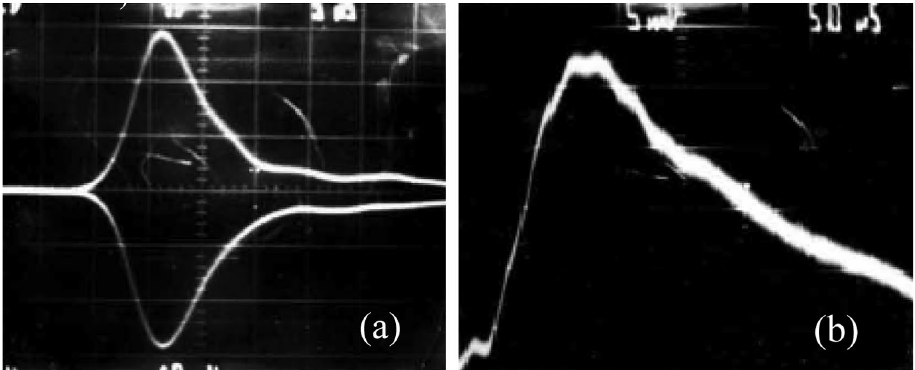
FIG. 3. (a) The signal from the transmission line terminating resistors. The horizontal scale is 5 ns = div and the vertical scale is 20 V = div . (b) The signal from the measuring coil. The horizontal scale is 50 ns = div and the vertical scale is 20 V = div .